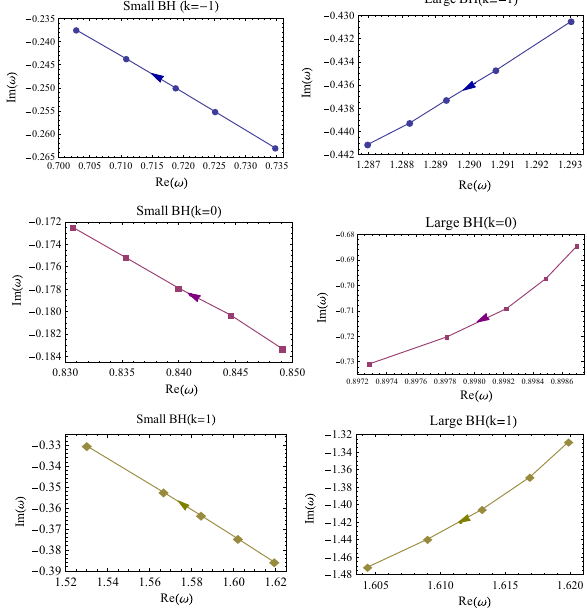
Fig. 5 The behavior of QNM frequencies for large and small black holes in the isothermal process. The arrow indicates the increase of the black hole